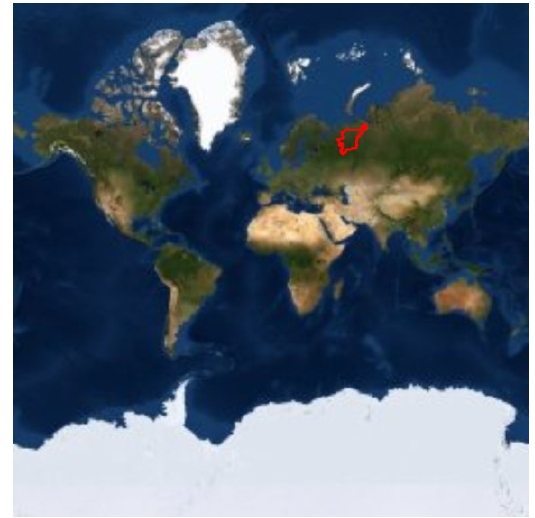
Figure 2. Location of the study area; Komi Republic is marked by red contour; Satellite imagery courtesy of the ESRI ArcGIS Online